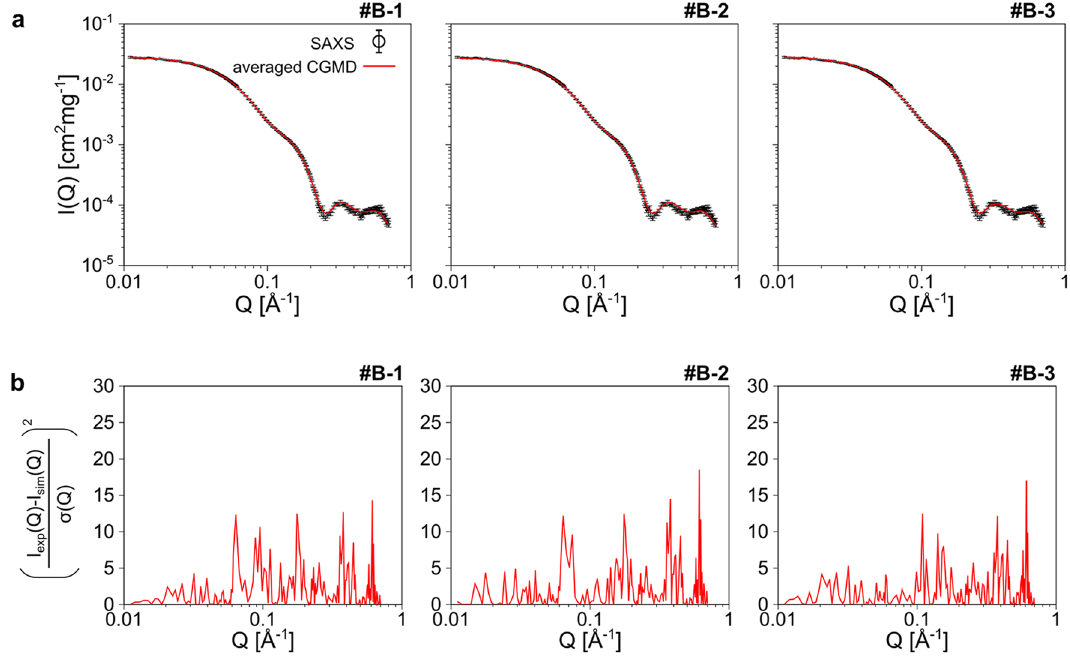
Figure 4. Time series of the SAS-CLIP with the improved criteria. The calculated SAXS profiles of three time series with long L t are shown. ( a ) Averaged SAXS profiles of the time series #B-1, #B-2 #B-3 (red lines) are compared with the experimental ones (black circle with error bars of s.d.). ( b ) The squared residuals of the averaged scattering intensities are